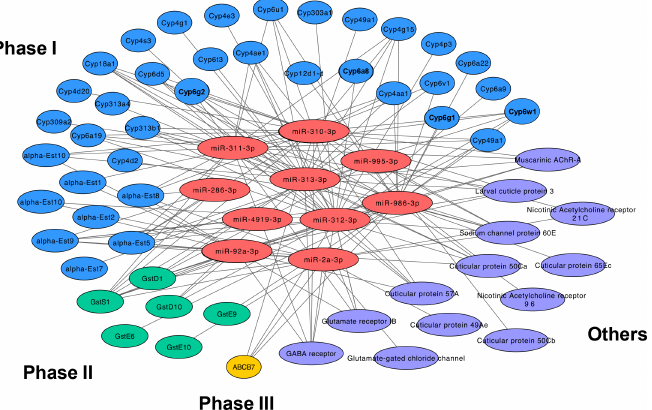
Fig 3. Putative xenobiotic metabolism-related target genes of differentially expressed miRNAs. The network consists of differentially expressed miRNAs and their corresponding target genes. Red hexagons represent differentially expressed miRNAs; blue circles represent target genes as phase I detoxification genes; green circles represent target genes encoding phase II detoxification genes; yellow circle represents target genes as phase III detoxification gene; and purple circles represent other genes affecting the insecticide insensitivity in insects. The network was generated and visualized in Cytoscape v3.6.0. Cyp6a8 , Cyp6g1 , Cyp6g2 ,and Cyp6w1 associated with DDT resistance are in